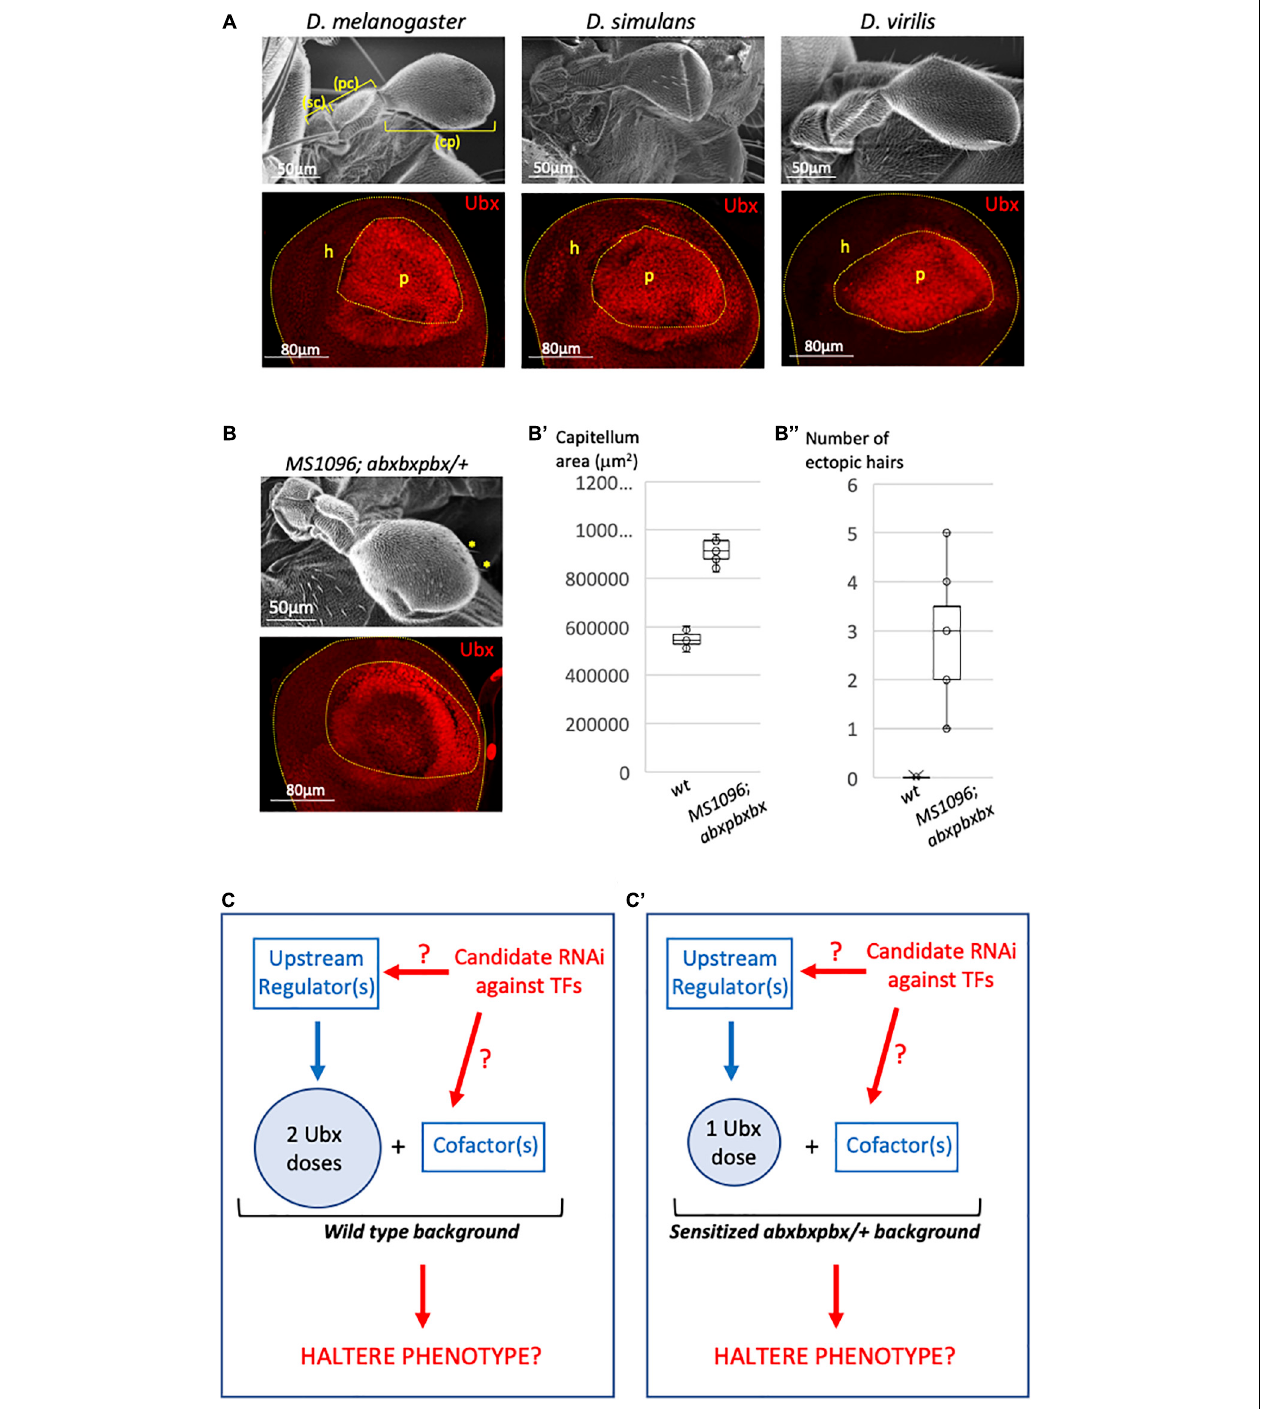
FIGURE 1 | Genetic model for the candidate Ubx regulators screening in the Drosophila haltere pouch. (A) Ubx (red) is expressed at high level in the pouch of the third instar larval haltere discs of Drosophila melanogaster , Drosophila simulans, and Drosophila virilis . The pouch (p) and hinge (h) regions will give rise to the capitellum (cp) and pedicellum (pc)+ scabellum (sc), respectively. Bottom images are illustrative confocal acquisition. Upper images are illustrative SEM acquisitions of adult halteres. (B) Haltere morphology (upper SEM picture) and Ubx expression profile (red, bottom confocal picture) in the haltere pouch in the abxbxpbx background context, as indicated. Yellow stars indicated ectopic wing-like bristles (B’) . Boxplot representation of the quantification of the adult haltere size in the wild type ( wt ) and abxbxpbx backgrounds. (B”) Boxplot representation of the quantification of the number of ectopic wing-like bristles in the wild type ( wt ) and abxbxpbx backgrounds. (C–C’) Model for the candidate RNAi screen that could affect upstream Ubx regulators or Ubx cofactors in the wt (C) or sensitized (C’) background. The RNAi screen is targeting transcription factors (TFs).